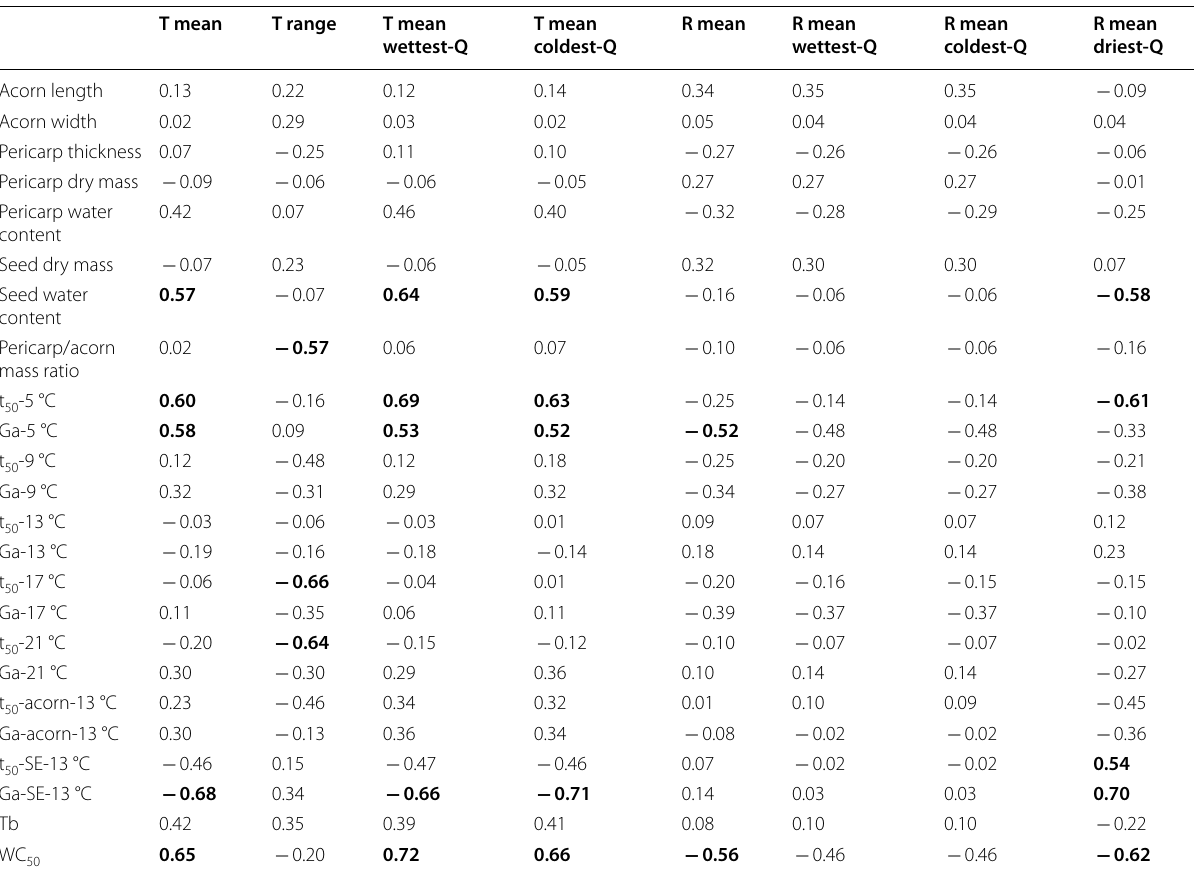
Table 4 Correlation matrix between seed traits and climatic variables associated with population sites. R coefficients. R values in bold indicate adjusted P values < 0.05. Ga, germination asynchrony; Q, quartile; t SE, shoot emergence; T, temperature; Tb, base temperature for